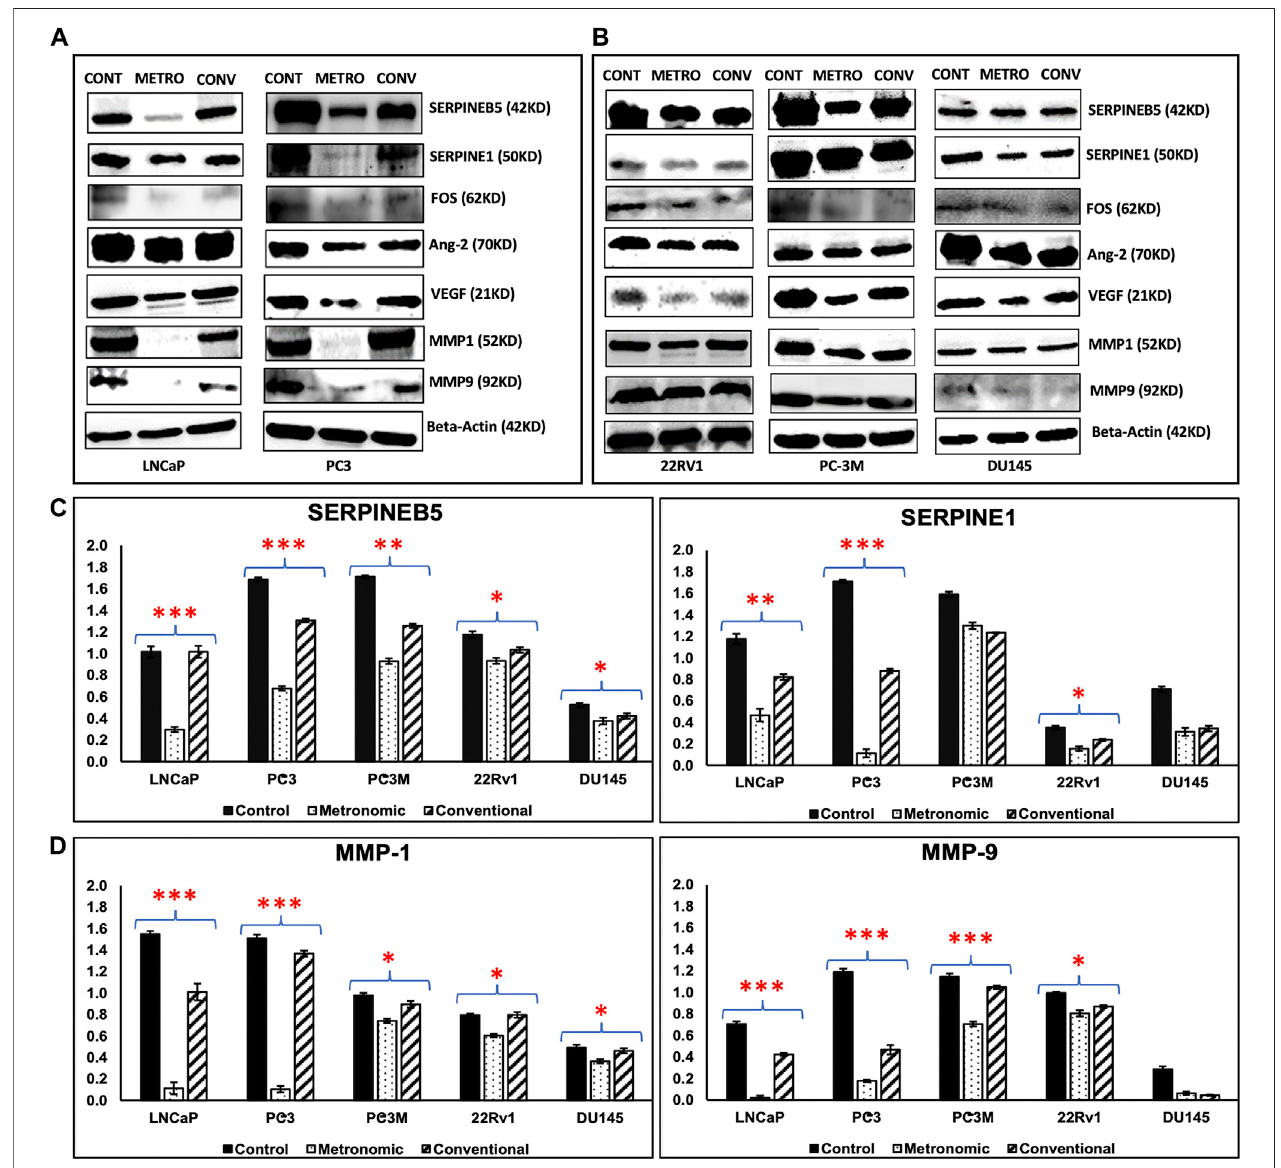
FIGURE 7 | Western blotting/Immunoblot analysis. Western blotting analysis results of proteins representing top DEGs for METRO-TOPO treatment in castration- resistantandandrogen-sensitivecelllines.Beta Actin wasusedasacontrol(housekeeping)gene. (A) Metastatic,androgen-sensitive LNCaP,mCRPC/NEPC PC-3; (B) mCRPC/NEPC PC-3M, DU145 and metastatic, androgen-sensitive 22RV1. (C, D, E) Densitometry plots METRO-TOPO dosing-associated DEGs compared to CONV and Control. SERPINB5, SERPINE1, FOS, ANG-2, VEGF, MMP1 and MMP9 were signi fi cantly downregulated in METRO-TOPO vs CONV-TOPO in PCa cell lines (* p ≤ 0.05, ** p ≤ 0.01, *** p ≤